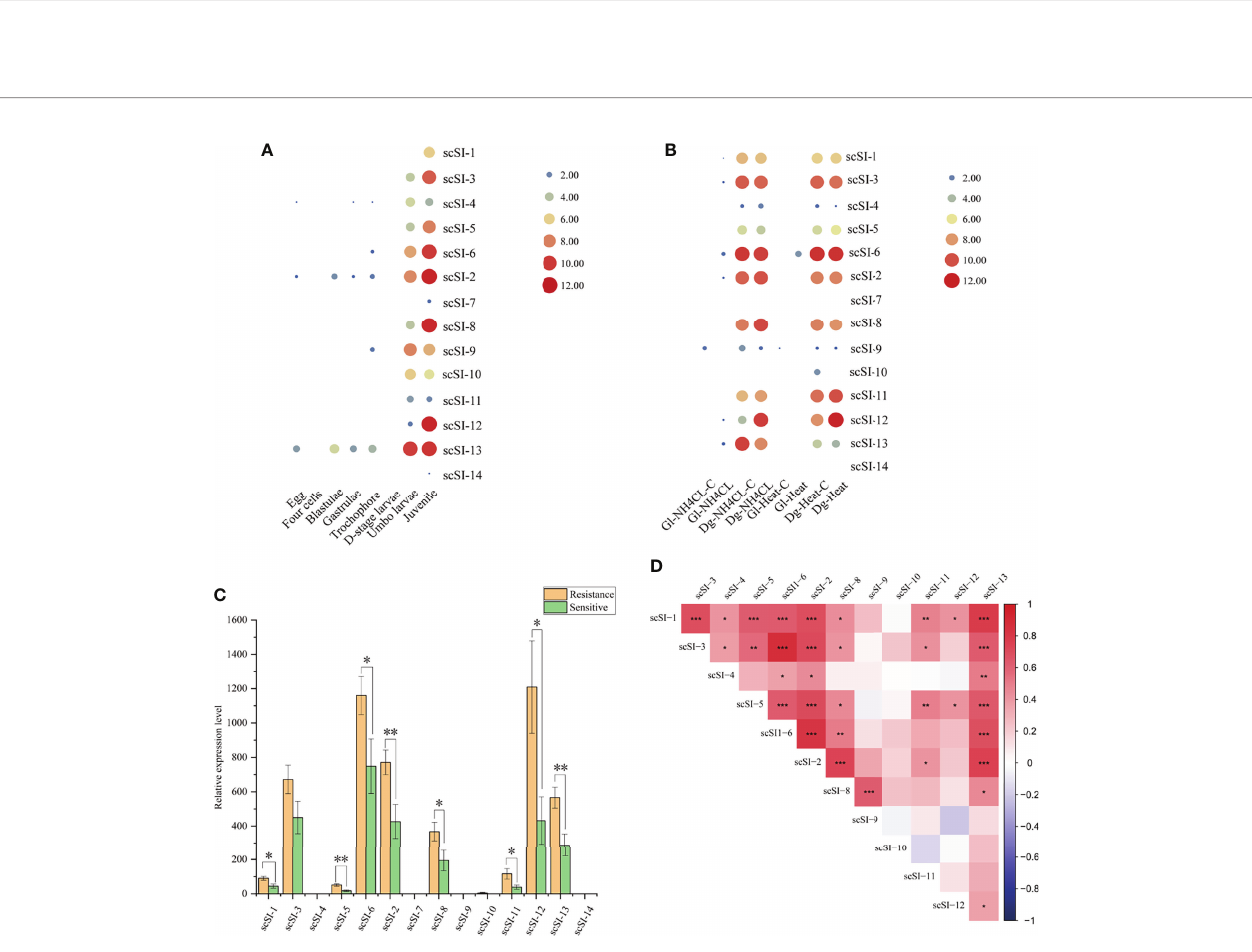
FIGURE 6 | Gene expression patterns and co-expression of Family I84 genes. (A) Expression patterns of genes at different development stages of egg, four cells, blastulae, gastrulae, trochophore, D-stage larvae, umbo larvae and juvenile after log 2 transformation; (B) Transcription level of Family I84 genes under the stress of ammonia nitrogen (180 mg/L with 0 mg/L as control) in gill (Gl-NH 4 CL, Gl-NH4CL-C) and digestive gland (Dg-NH 4 CL, Dg-NH4CL-C); high temperature (32°C with 22°C as control) in gill (Gl- heat, Gl-heat-C) and digestive gland (Dg-heat, Dg-heat-C) after log2 transformation; (C) Gene expression level for resistant and sensitive groups (n = 15 per group) of razor clam juveniles after V. parahaemolyticus infection, one and two asterisk represent the signi fi cant level lower than 0.05 and 0.01, respectively; (D) Co-expression analysis of I84 family genes in resistant and sensitive groups (n = 30 in total) of juveniles under V. parahaemolyticus infection, the darker of the block, the much stronger correlation are between them, *, ** and *** means the p valve for correlation coef fi cient lower than 0.05, 0.01 and 0.001,